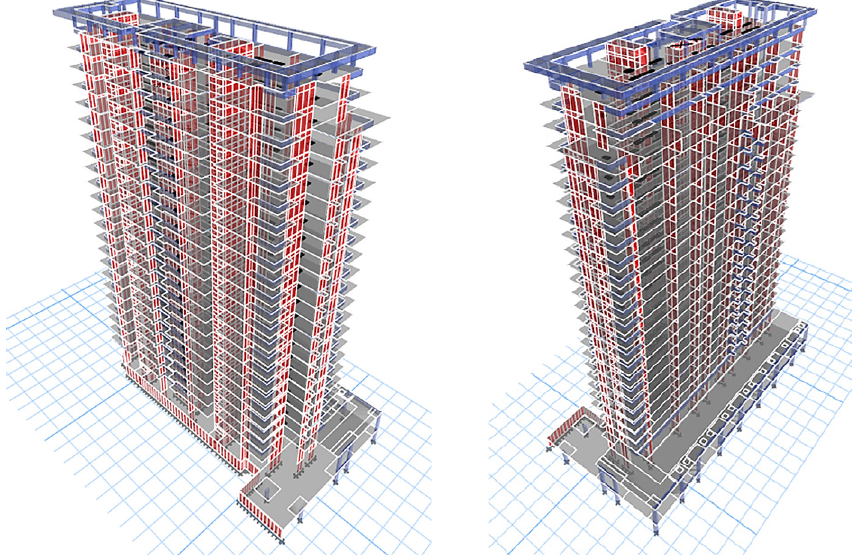
Figure 3. Three-dimensional (3D) model of the high-rise